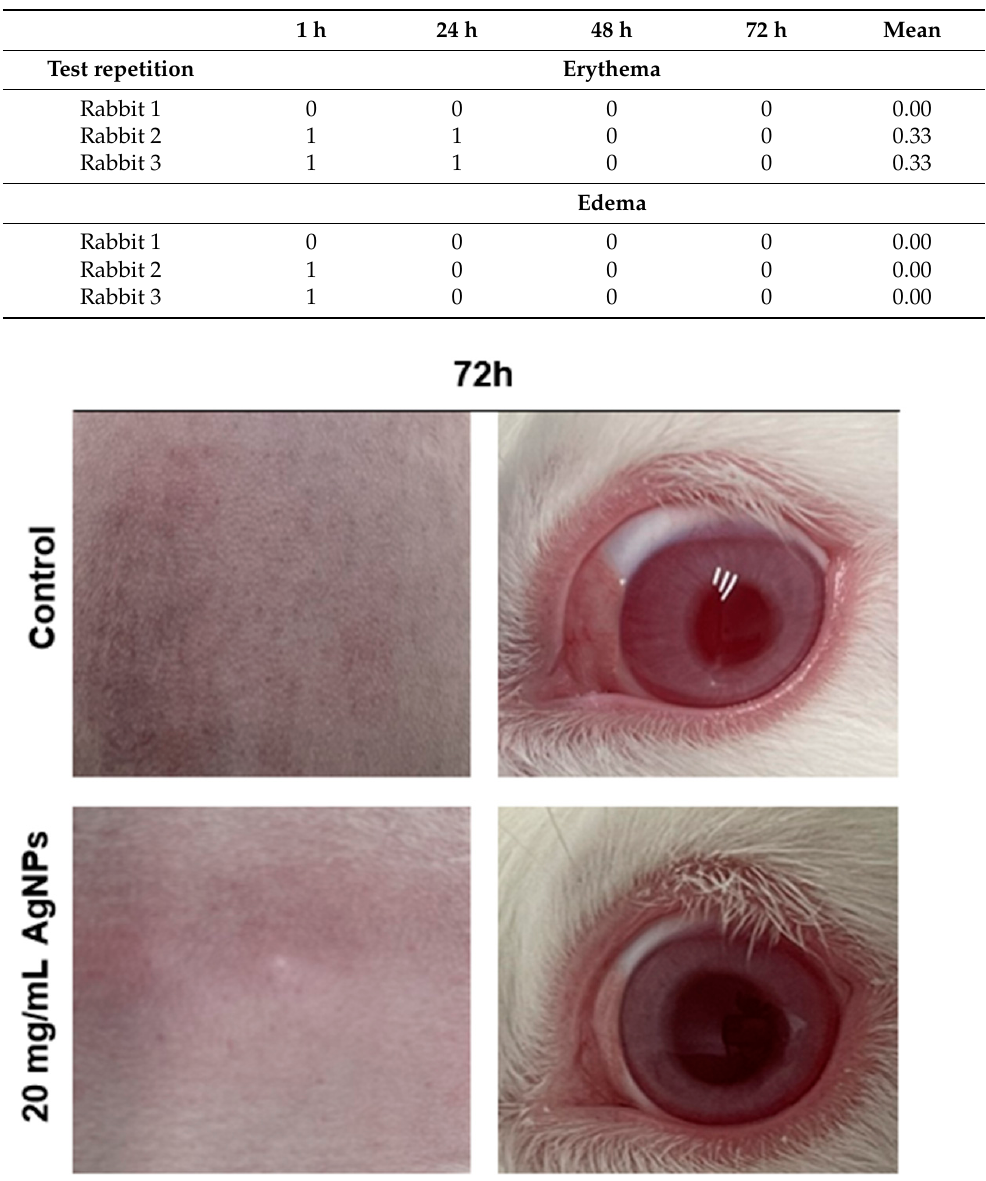
Table 7. Rabbit dermal response after AgNPs treatment.